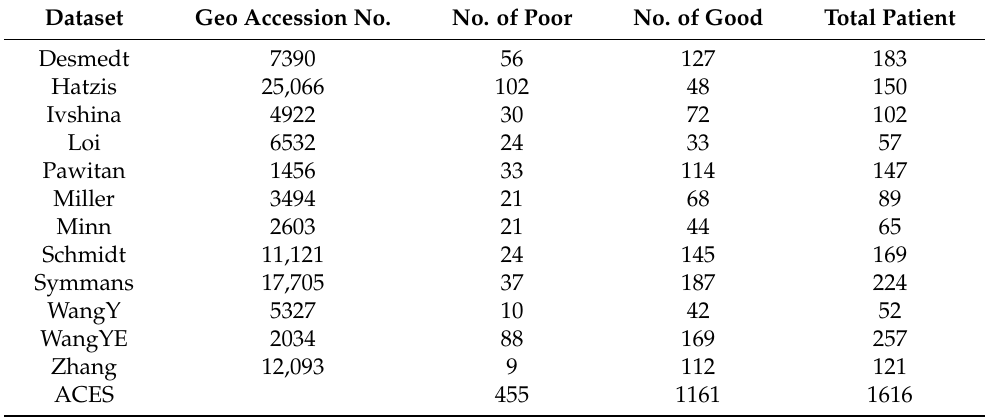
Table 1. specification of the studies in